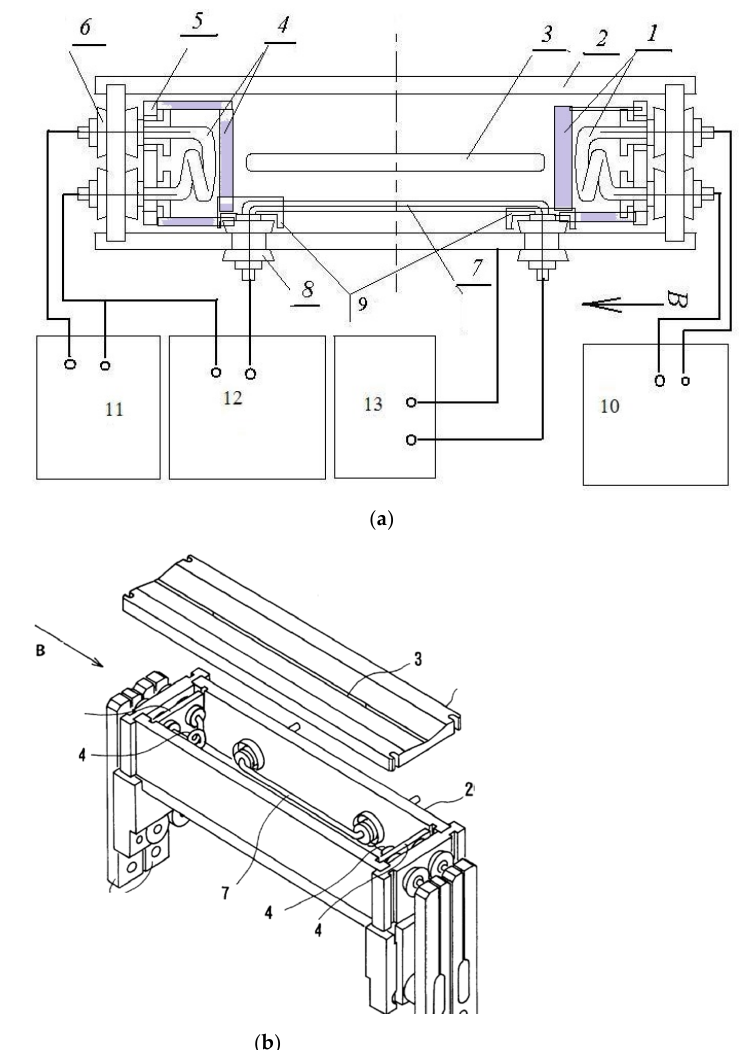
Figure 1. ( a ) Schematic of small anode ion source with power supplies, and ( b ) isometric view. 1 and 4—cathodes, 2—anode body, 3—emission slit, 5—cathode shields, 6—cathode insulators, 7—small anode, 8—small anode insulators, 9—small anode shields, 10 and 11—cathode power supplies, 12—gas discharge power supply, 13—small anode bias power supply.